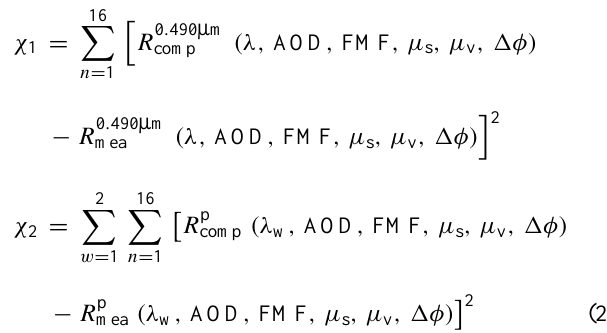
Fig.1. Flowchart of aerosol optical properties from multi-angular, multi-spectral, total and Fig. 1. Flowchart of aerosol optical properties from multi-angular, polarized radiation measurements from POLDER multi-spectral, total and polarized radiation measurements from Fig.2. Two-dimensional polarized reflectance correlation diagram in terms of the FMF (0.0, POLDER. Fig. 2. Two-dimensional polarized reflectance correlation diagram 0.2, 0.4, 0.6, 0.8, 1.0) and AOD (0.0, 0.1, 0.2, 0.3, 0.5, 0.8, 1.0, 1.2, 1.5, 2.0) for two wavelengths in terms of the FMF (0.0, 0.2, 0.4, 0.6, 0.8, 1.0) and AOD (0.0, of 0.675  m, 0.870  m in the calculation for a solar zenith angle is 50°, a satellite viewing angle is 0.1, 0.2, 0.3, 0.5, 0.8, 1.0, 1.2, 1.5, 2.0) for two wavelengths of 30°, and the azimuth relative angle is 180°, the type of the surface is black surface, 0.675µm, 0.870.µm in the calculation for a solar zenith angle is From the 2-dimensional diagram, for a given geometry, it is noted that there is a 50 ◦ , a satellite viewing angle is 30 ◦ , and the azimuth relative angle is 180 ◦ , the type of the surface is black surface. strong sensitivity of the combination of polarized reflectance at 0.675  m, 0.870  m to